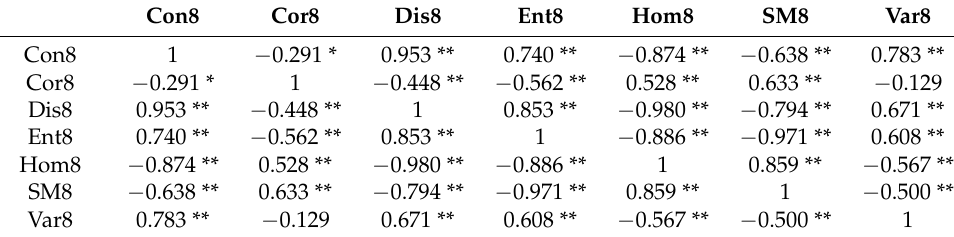
Table 13. Correlation coefficient matrix of texture features in the near-infrared narrow band.